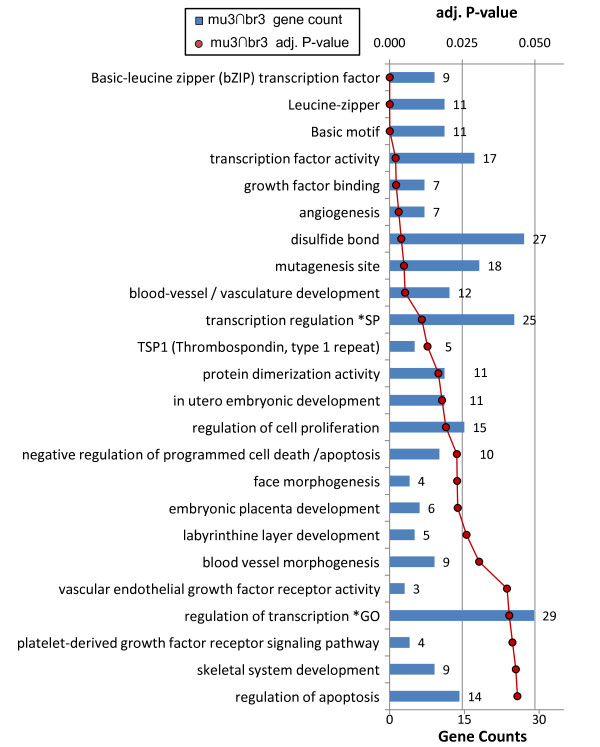
Functional groups significantly enriched among genes upregulated in both Spalax muscle and brain after 3% 6hrs hypoxia (mu3∩br3). Red line chart represents Benjamini adjusted P-values for specific ontology categories. Blue bars denote gene counts. A total of 75 genes are associated with at least one significant group. Enrichment of the same term may be detected using different databases (e.g. GO, Swiss-prot keywords, InterPro, Smart, KEGG).